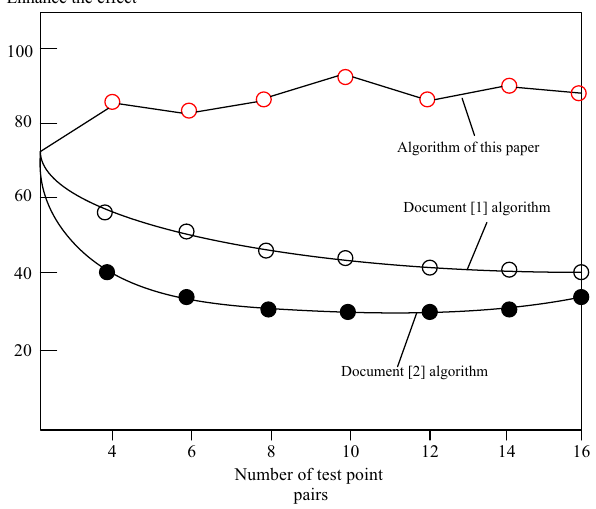
Figure 6: Image edge detail enhancement recognition rate